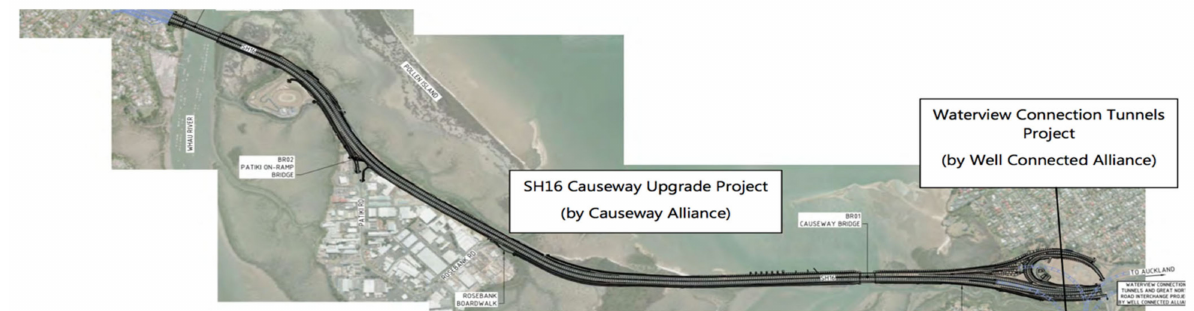
Figure 5. Main Highway Upgrade and Bridge Construction Project master plan [61].